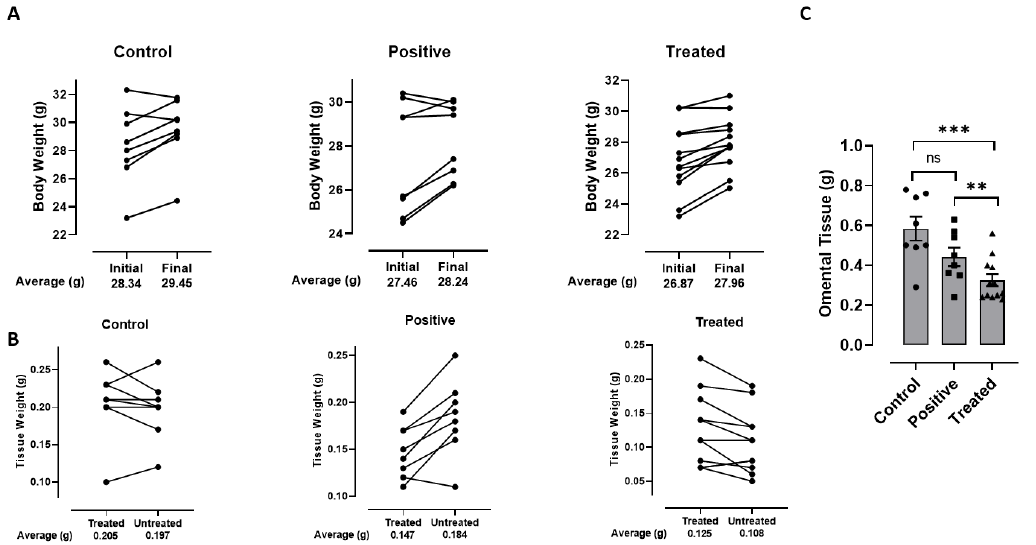
Figure 2. In vivo effect of GATA3 inhibition on ( A ) total animal weight between start and end of experiment, ( B ) weight of SAT tissue between treated (site of injection) and untreated (control) sites, and ( C ) weight of omental tissue. Bar graphs show paired data for each mouse for n = 6–12 animals per group. Statistical analysis was determined by paired ( A , B ) and unpaired ( C ) t -test (** p < 0.02, *** p < 0.01).